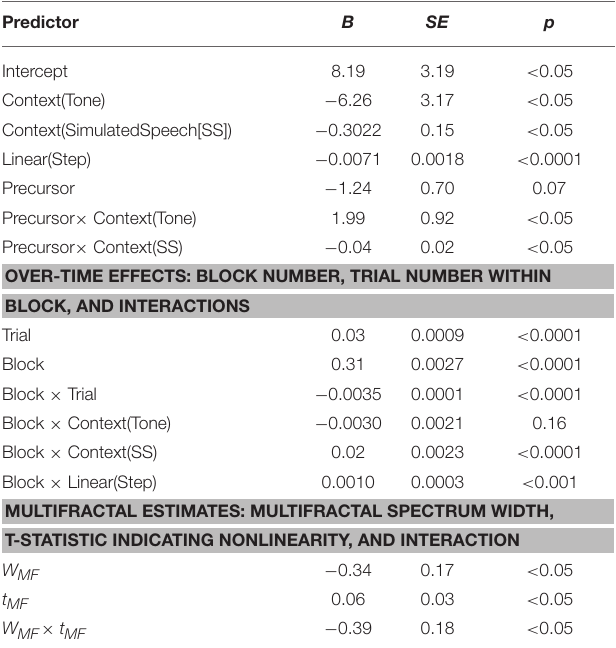
TABLE 2 | All coefficients from Poisson regression predicting cumulative “GA” responses with multifractal estimates.